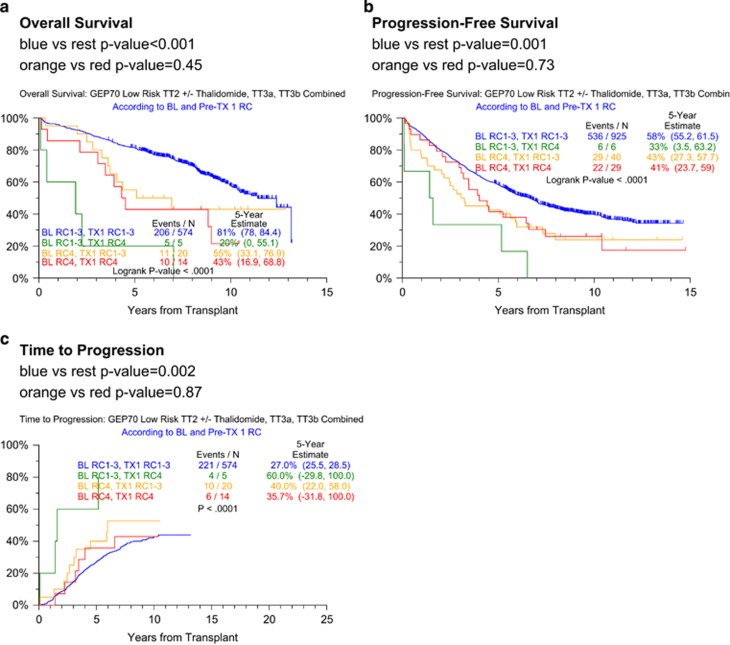
Overall survival, progression-free survival and time to progression in GEP70-defined low-risk myeloma according to baseline and transplant RCs. (a) Overall survival is superior with RC1–3 at both time points; (b) progression-free survival is superior with RC1–3 at both time points; (c) time to progression most shallow with RC1–3 at both time points.